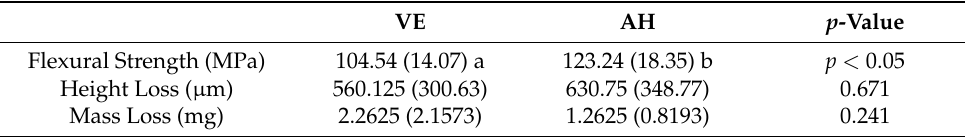
Table 2. Mean values and standard deviation of flexural strength and wear. VE AH p -Value Flexural Strength (MPa) 104.54 (14.07) a 123.24 (18.35) b p < 0.05 Height Loss ( µ m) 560.125 (300.63) 630.75 (348.77) 0.671 Mass Loss (mg) 2.2625 (2.1573) 1.2625 (0.8193)